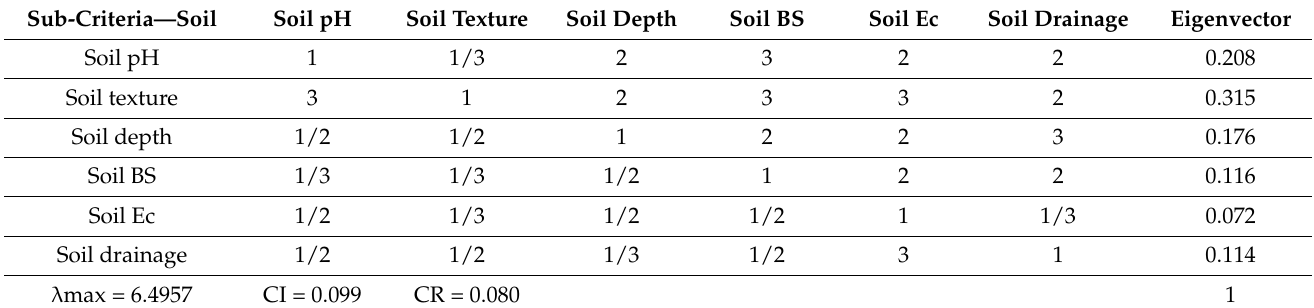
Table 6. Pair-wise comparison matrix of the sub-criteria for soil.